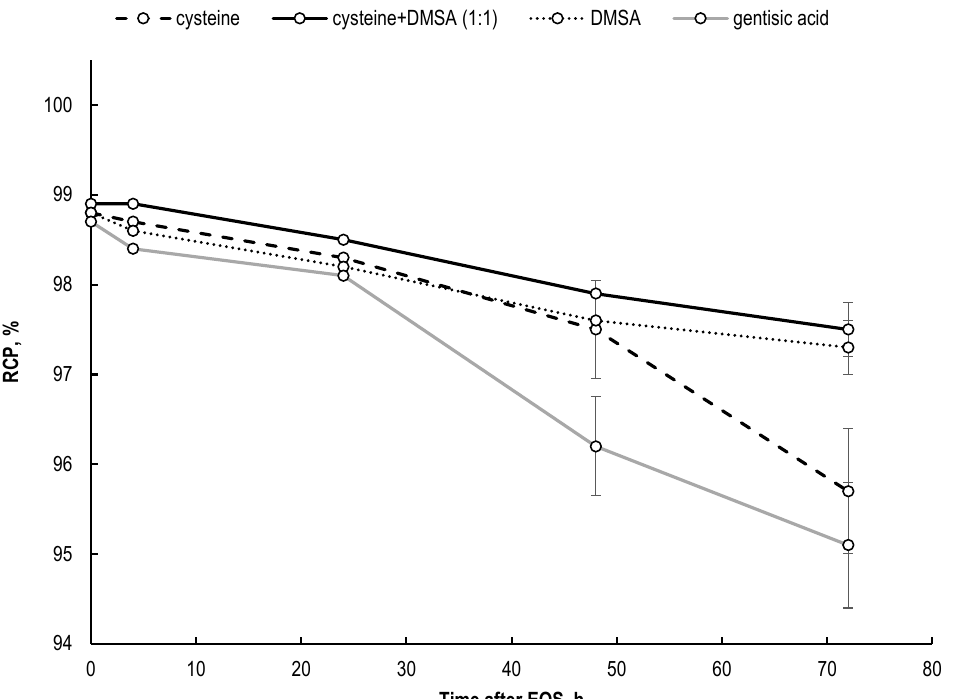
Figure 14. Influence of the addition of various quenchers on the maintenance of [ 177 Lu]Lu-PSMA-617 radiochemical purity over time. Samples volume—1 mL, 177 Lu activity in the sample—470 MBq, 100 μ g of PSMA-617, pH 4.5, C(Na-acetate) = 0.03 mol/L (RCP value is presented as mean ± SD, n = 3). No statistically significant difference was observed in the maintenance of [ 177 Lu]Lu- PSMA-617 radiochemical purity when cysteine and DMSA were used in 1:1 and 1:½ molar